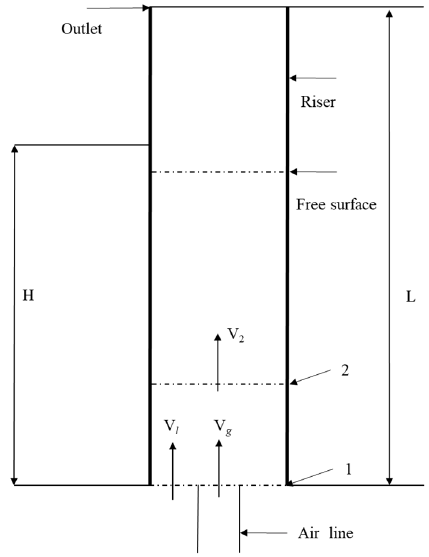
Figure 12. Theoretical model of pneumatic lifting pump.